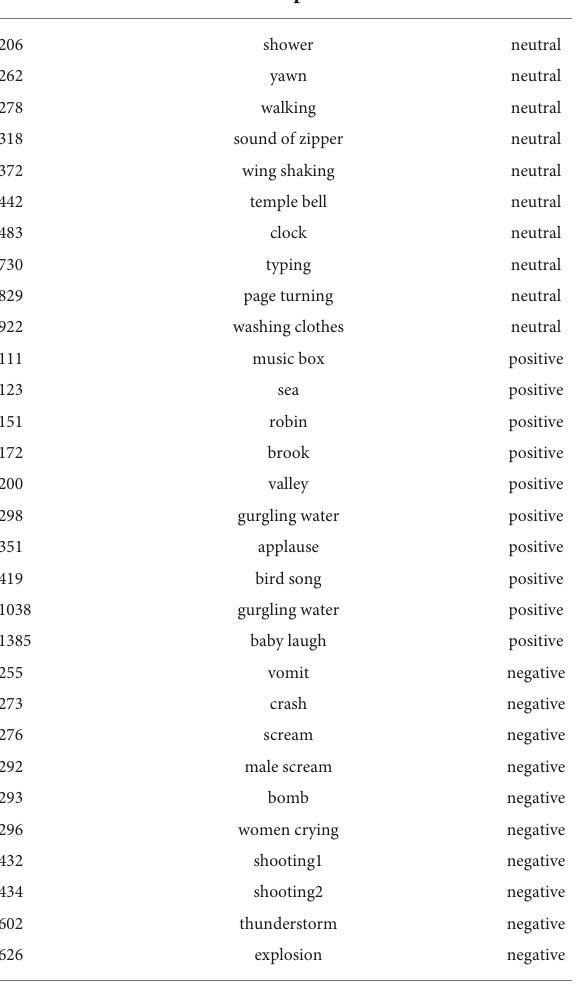
TABLE A1 List of emotional auditory al sounds used in the current